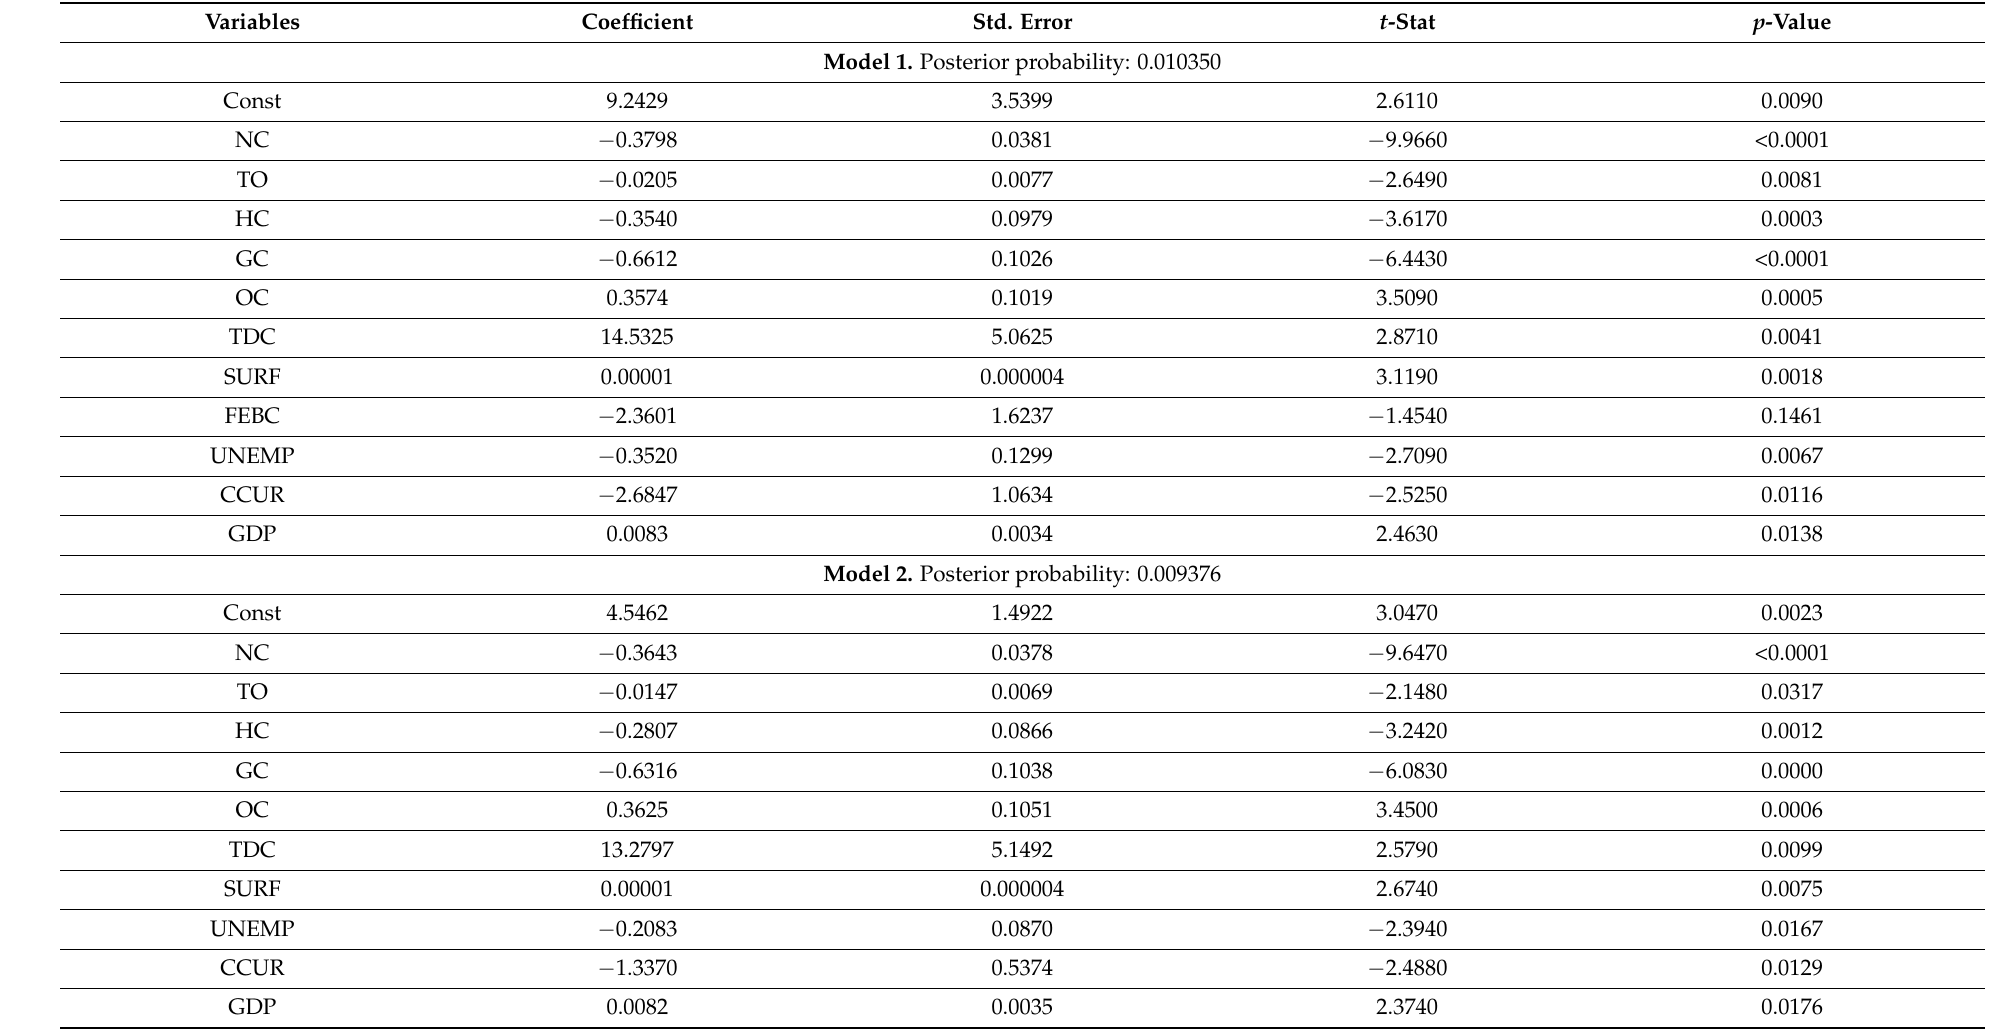
Table A3. Posterior estimates of top 3 models for renewable consumption determinants in